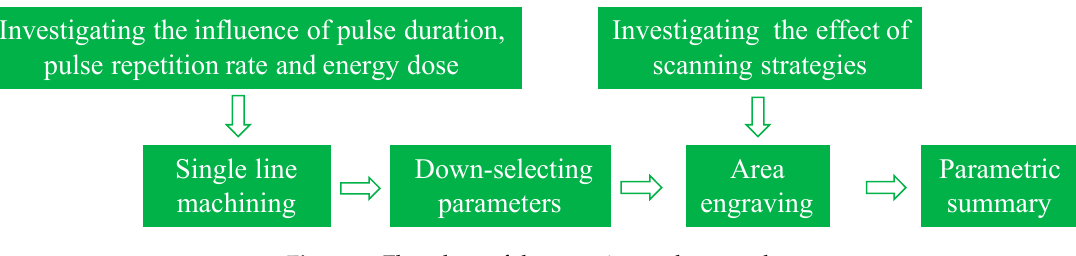
Figure 2. Flowchart of the experimental protocol.